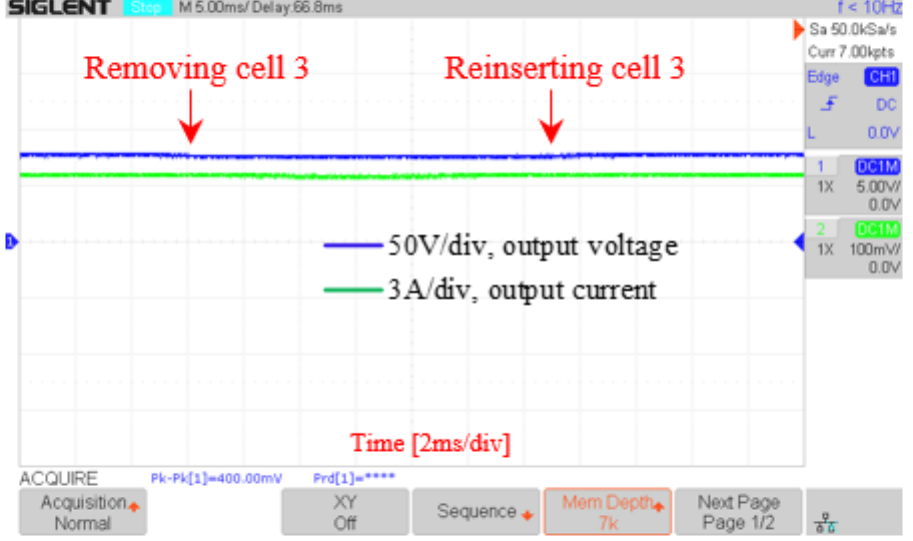
Figure 37. Load voltage and load current waveforms when reinserting cell 3.